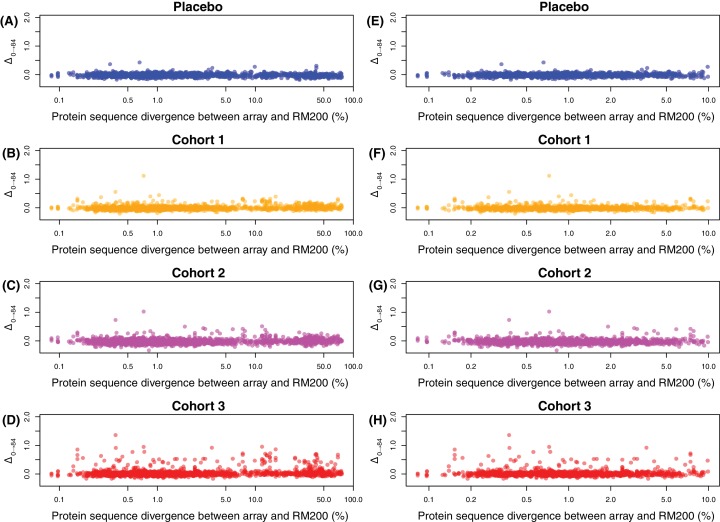
Effect of divergence between array sequences and RM200 proteins on detected changes in IgG binding.Each panel shows the divergence between the protein sequence on the array and the closest orthologue in the RM200 strain, on a logarithmic scale on the horizontal axis, and the within-cohort median Δ0→84, on the vertical axis. Two plots are shown for each cohort, focussing on different ranges of sequence similarity: between 0–100% divergence (A–D), and 0–10% divergence (E–H). No clear relationship between sequence divergence and change in IgG binding is evident, suggesting measurements from the array are not biased towards the probes sharing higher sequence identity with proteins in the WCV, despite being designed using a divergent set of strains.